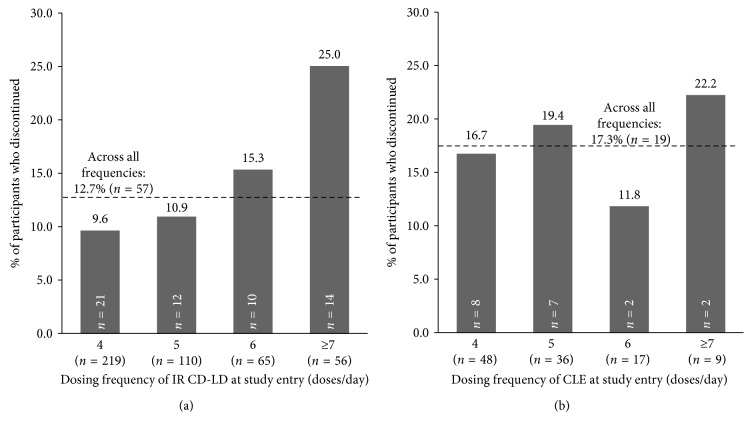
Proportions of participants who discontinued during dose conversion based on daily LD dose frequency at study entry during the conversion from IR CD-LD (a) or CLE (b). Proportions were calculated using the total number of participants who entered dose conversion (n=450 in (a) n=110 in (b)). The numbers of participants who discontinued from each dose range are indicated within each bar. The dashed lines represent the overall rate of discontinuation during dose conversion in each study.